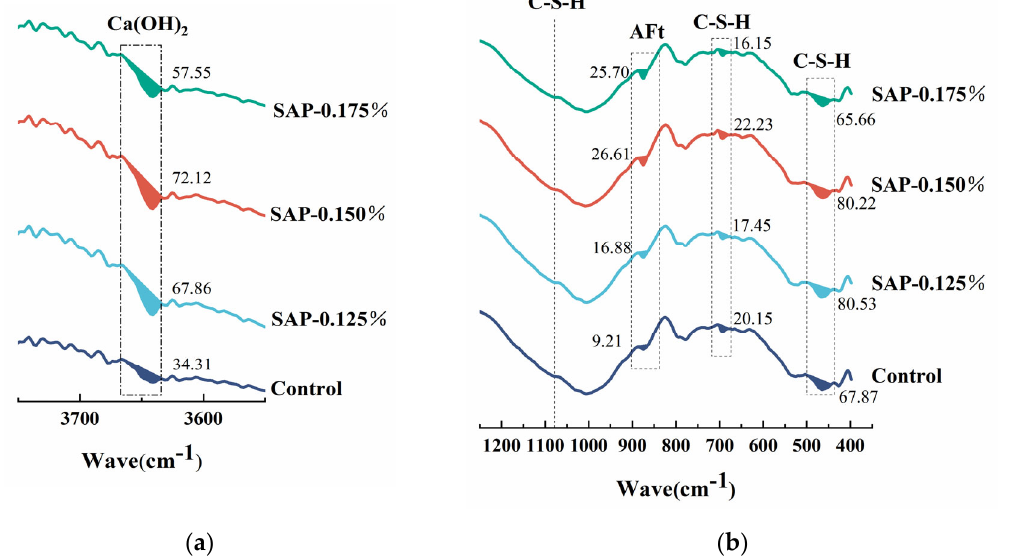
Figure 12. FTIR spectrum of pavement concrete with different SAP dosage after 75 cycles: ( a ) the peak area of Ca(OH) 2; ( b ) the peak area of C ‐ S ‐ H and AFt.